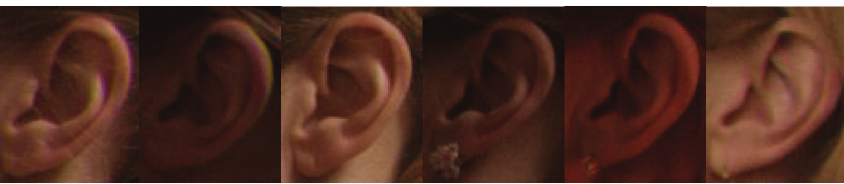
Figure 2: Typical cropped ear images from one